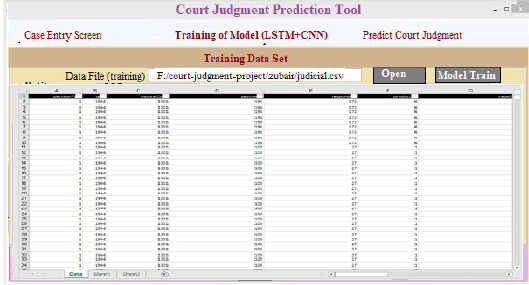
Figure 13. Create an interface that loads the training data.